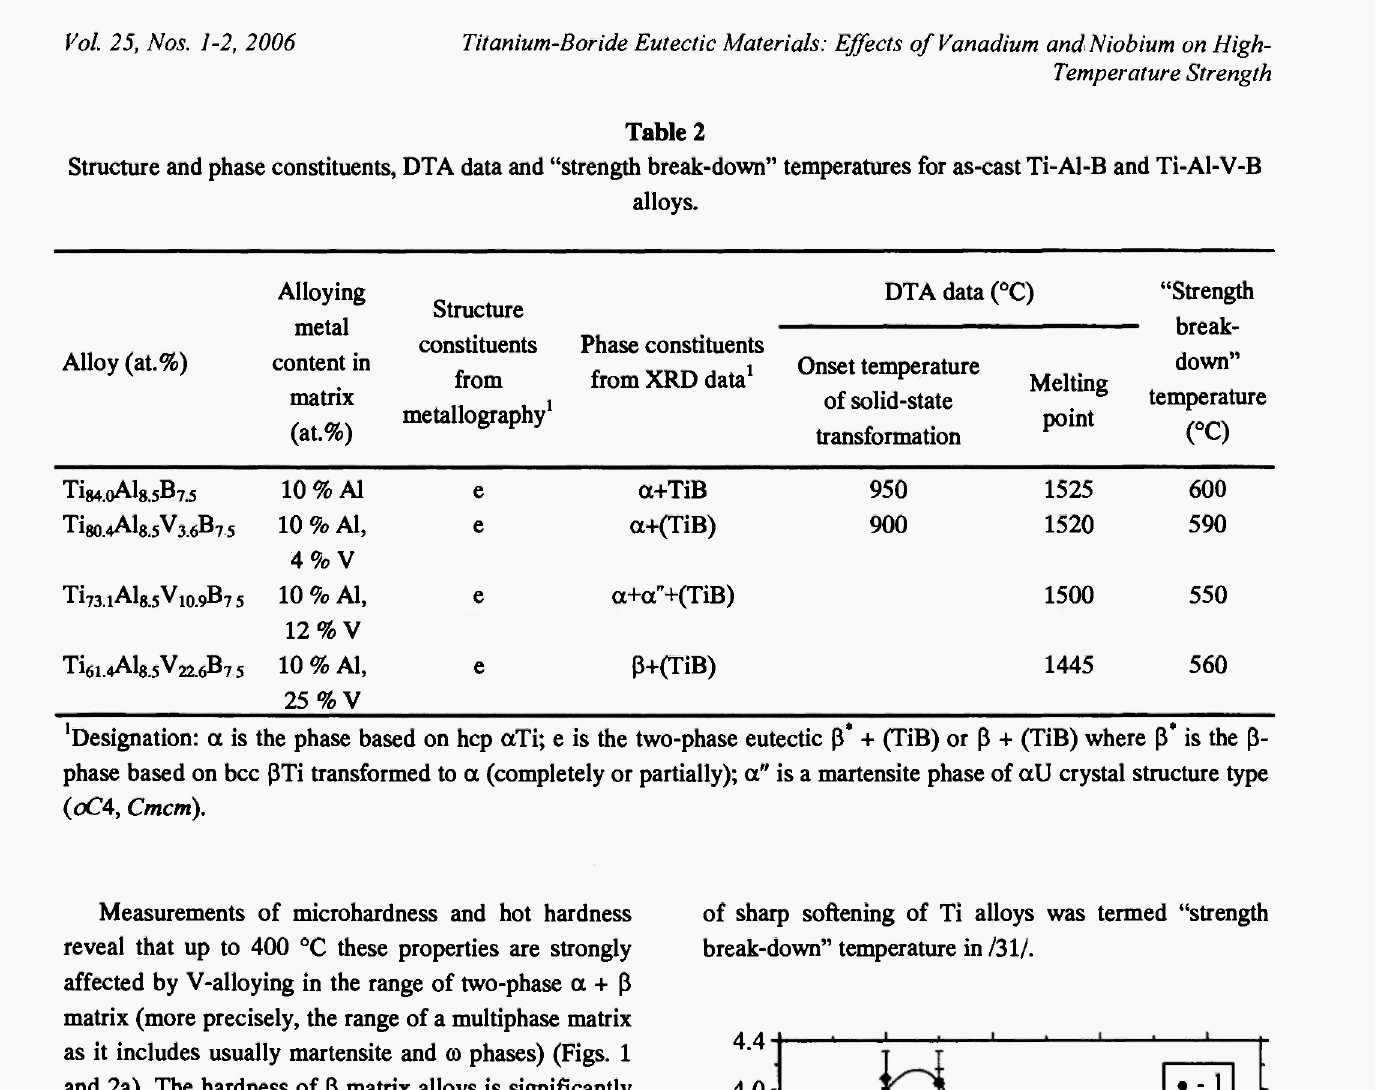
Structure and phase constituents, DTA data and "strength break-down" temperatures for as-cast Ti-Al-B and Ti-Al-V-B alloys.